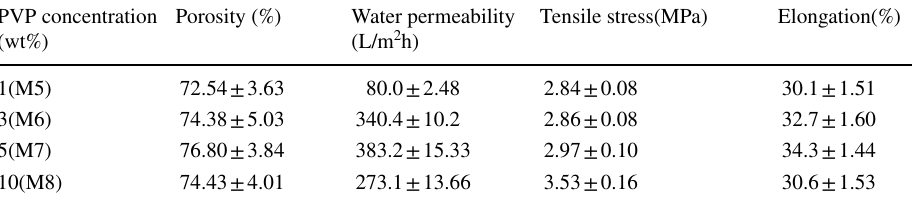
Table 4 Water permeability, porosity, tensile stress and elongation of PVDF membranes produced with different quenching